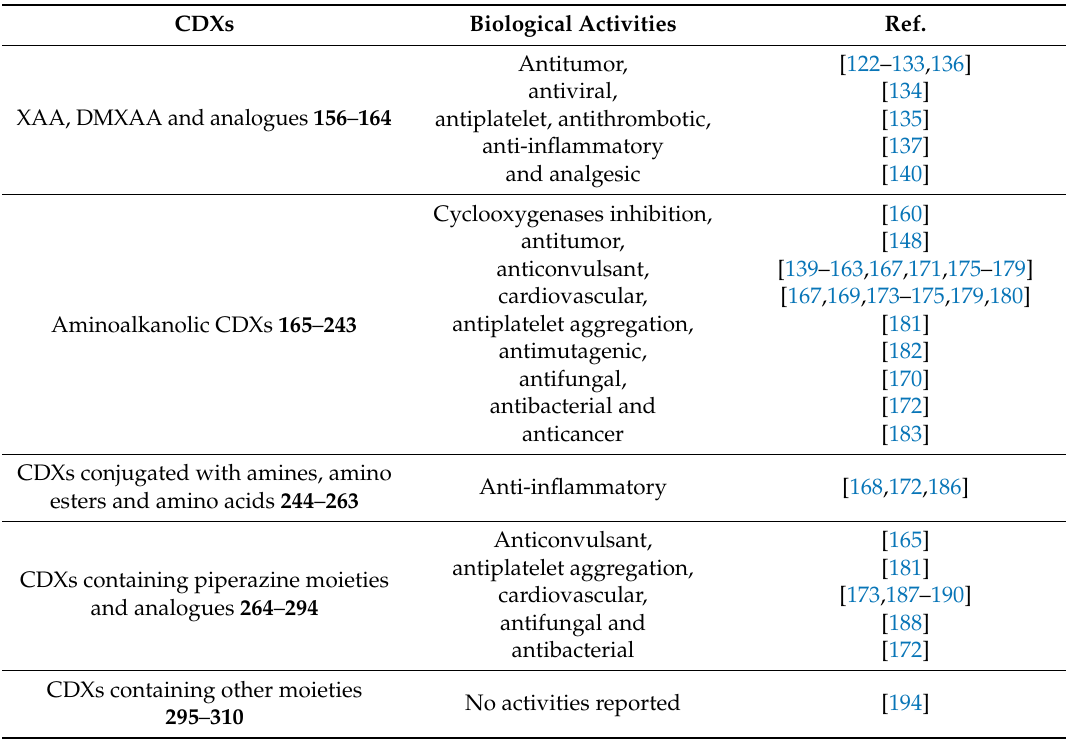
Table 2. Summary of the biological activities of synthetic CDXs obtained by binding/coupling chiral moieties to the xanthone